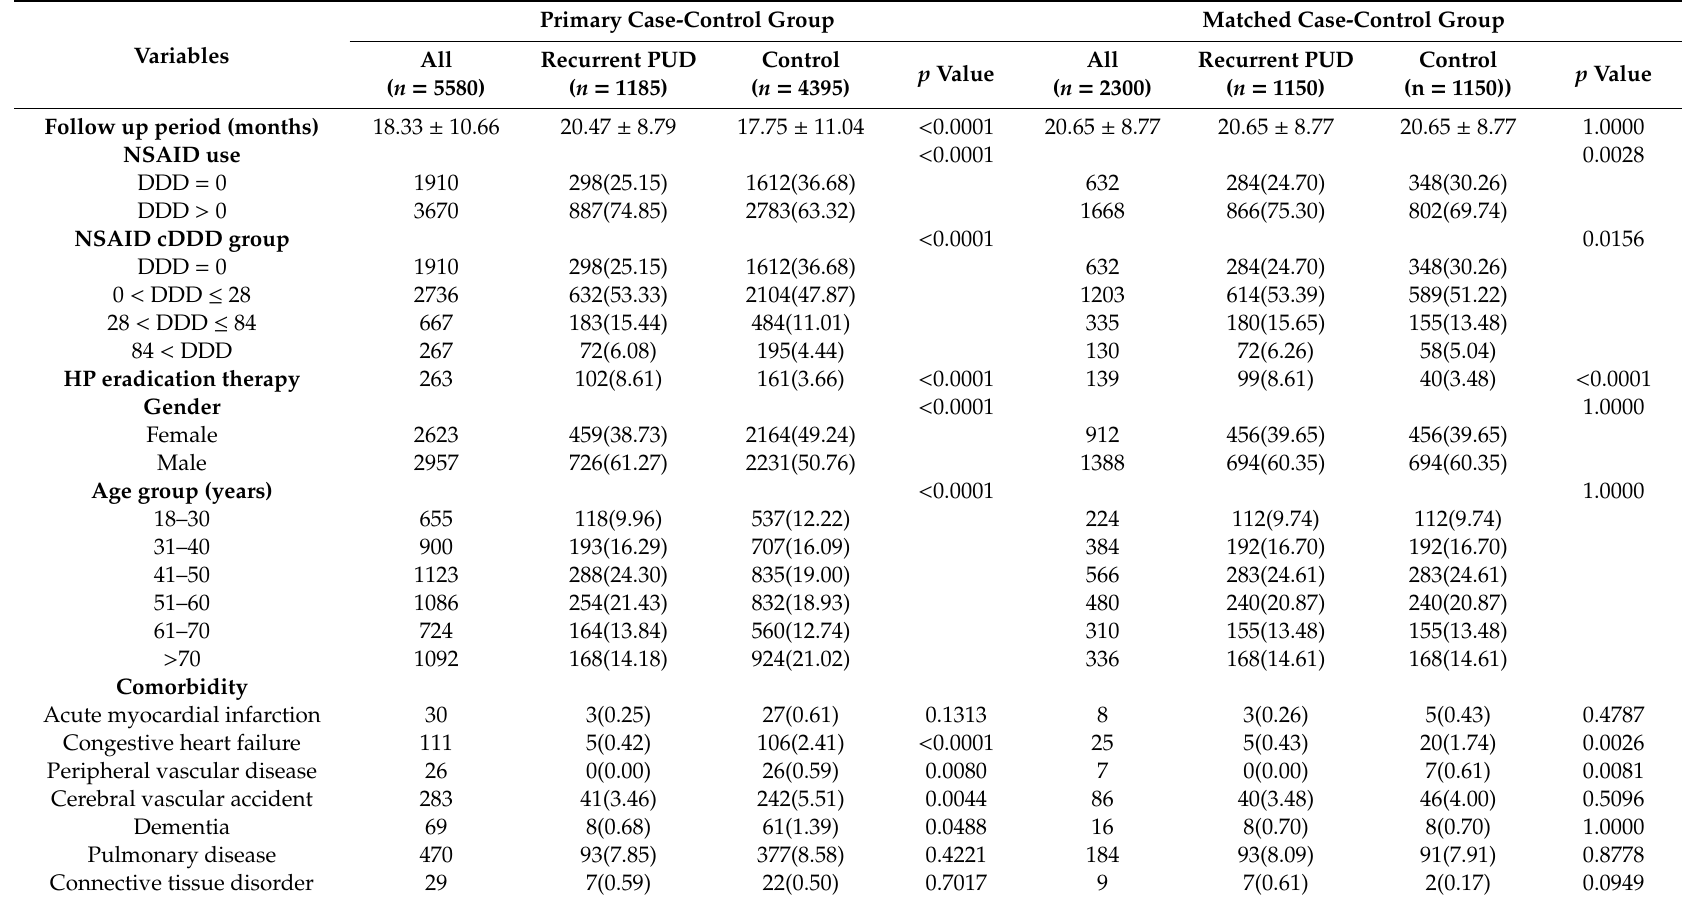
Table 1. Characteristics between patients with and without recurrent peptic ulcer